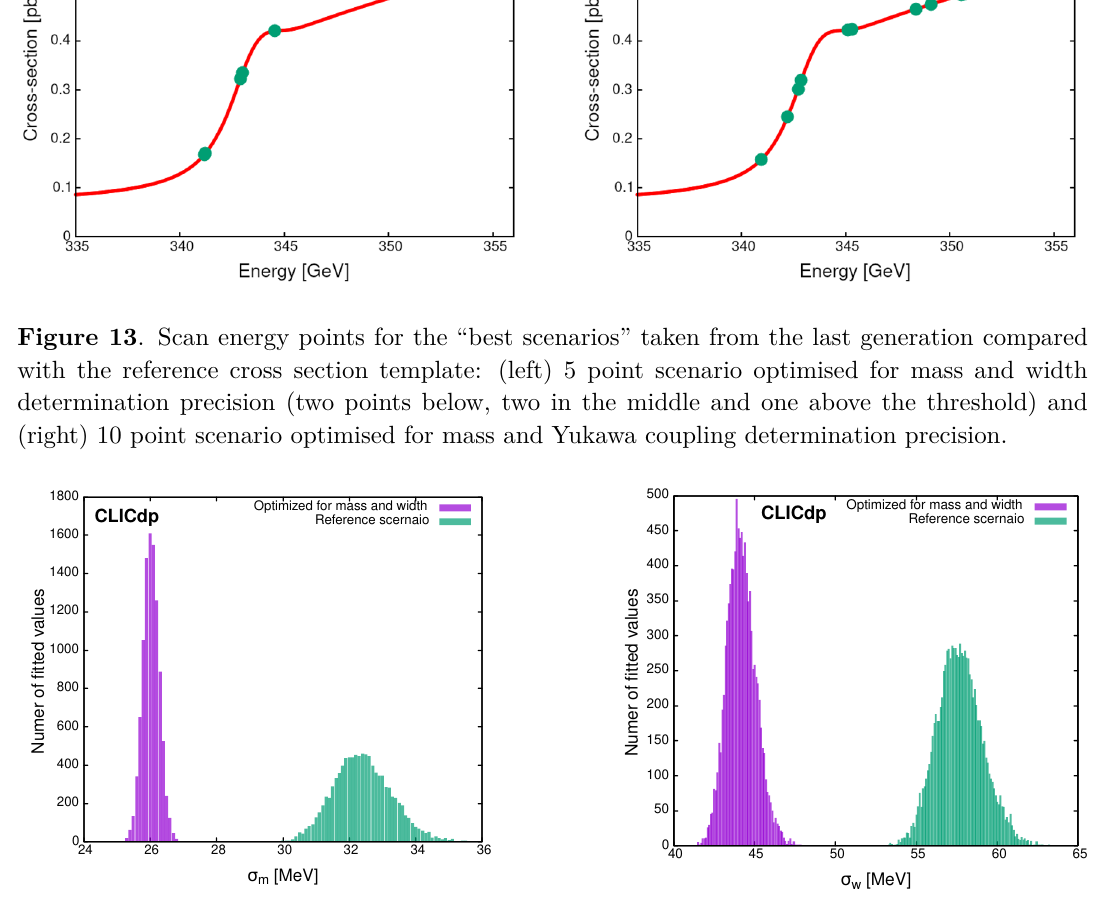
Figure 14 . Uncertainty distribution for mass (left) and width (right) measurement, for five- point scan scenario optimised for mass and width measurement (see figure 13), compared with the distributions for the reference